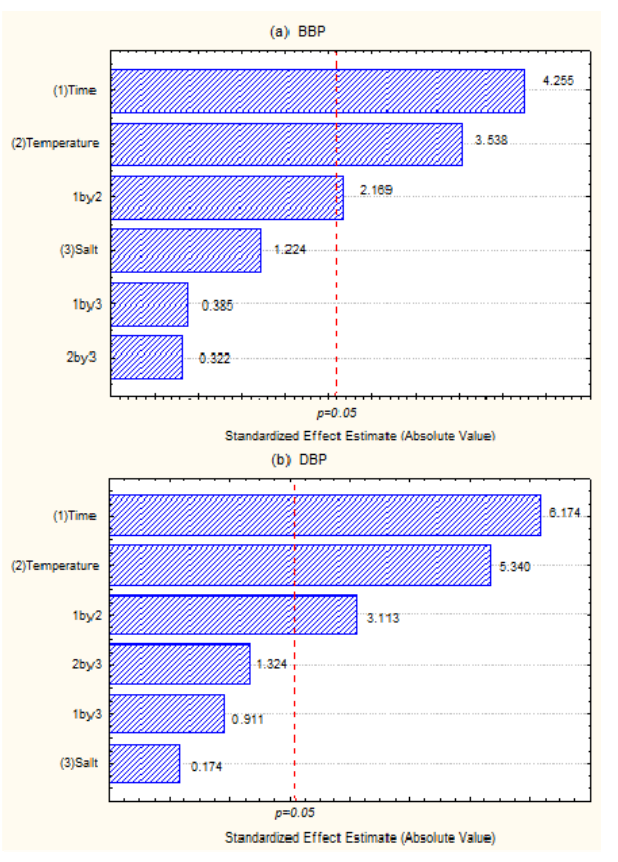
Figure 2. Pareto charts for (a) BBP and (b) DBP obtained from the 2 3 factorial experiment